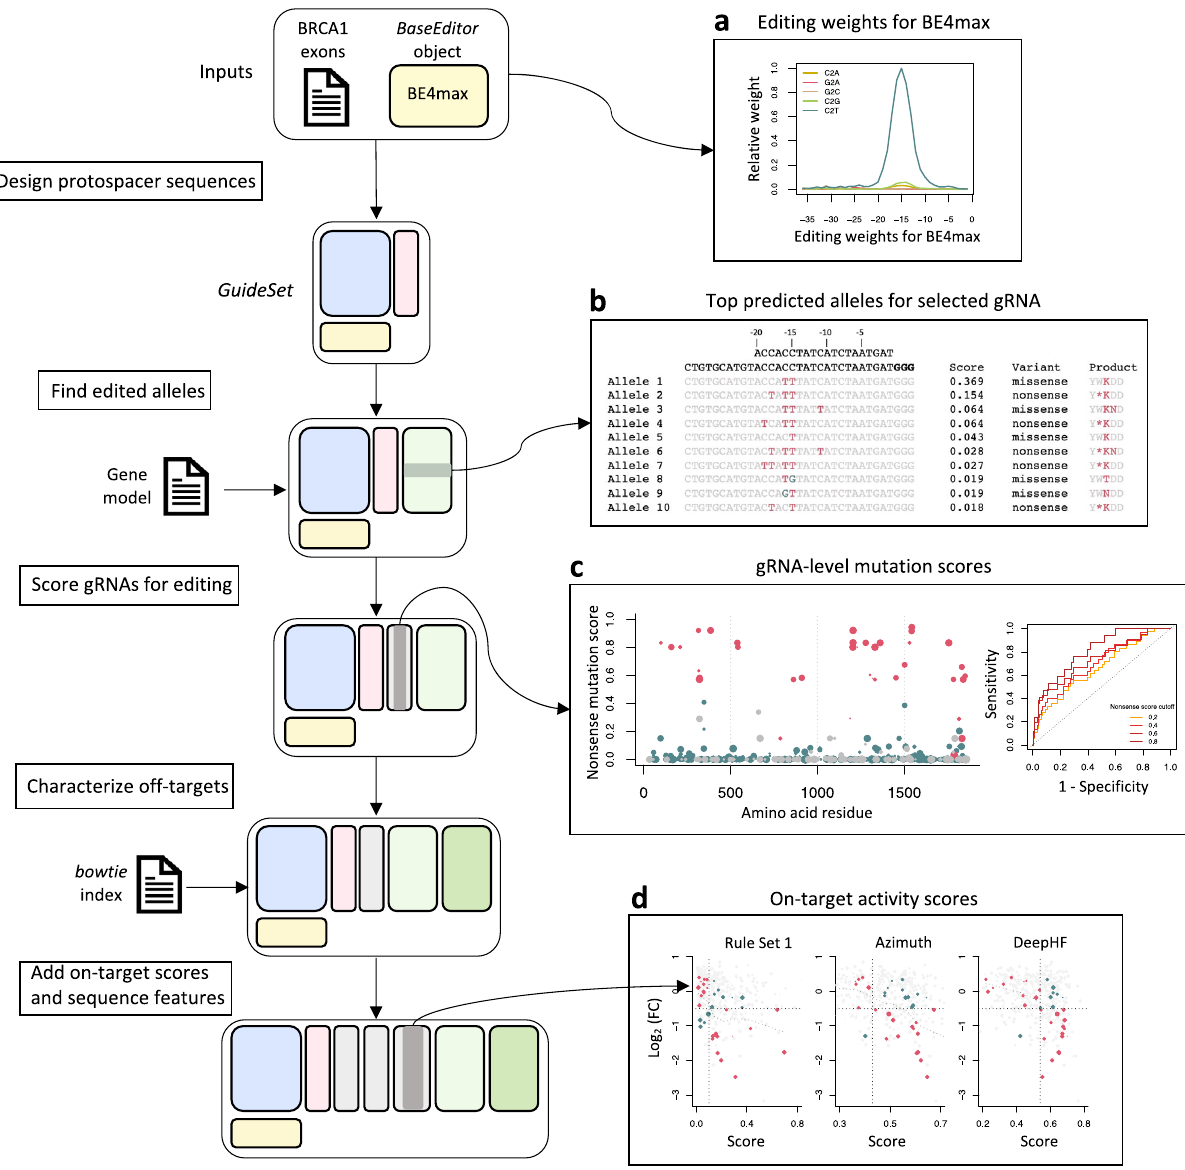
Fig. 4 | crisprDesign work fl ow to design gRNAs tiling BRCA1 using the base editor BE4max. On the left: schematic showing the major steps involved in designing BE4max gRNAs targeting BRCA1 . Two inputs are required: DNA sequences of BRCA1 exons and a BaseEditor object from crisprBase . a Editing weights for the BE4max base editor from crisprBase . b 10 top predicted edited alleles for one selected gRNA as returned by crisprDesign . The wildtype allele and the protospacer sequence are positioned at the top of the fi rst column, with the PAM sequence highlighted in bold. Edited nucleotides are highlighted in red (C to T)andblue(CtoG).Editingscores,variantannotations,andproteinproductofthe edited alleles are also shown. c Onthe left, gRNA-level nonsense mutation scoreas calculated by crisprDesign . Colors represent variant classi fi cation: nonsense in red, missense in blue, silent in gray. The size of the dot is proportional to the on-target